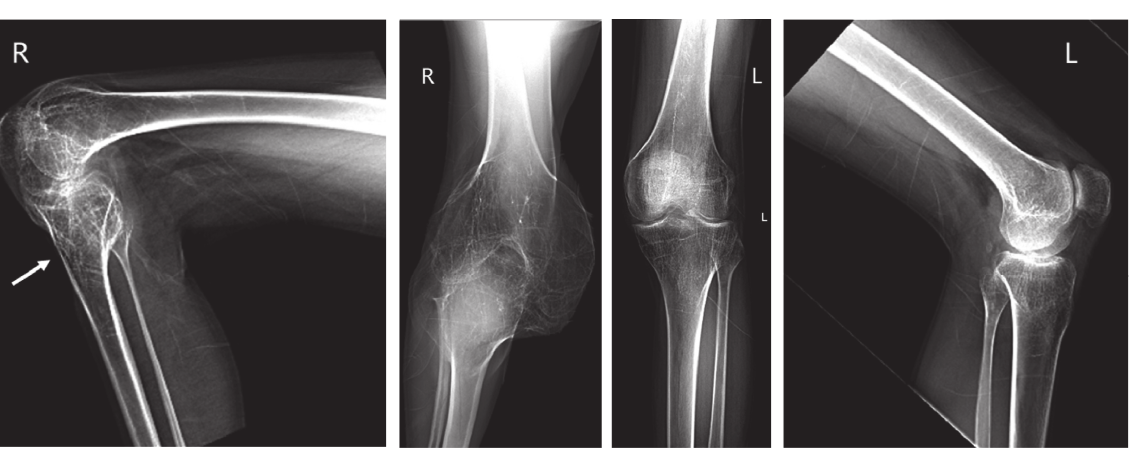
Figure 4: X-ray photography on both knees of Patient 3 before